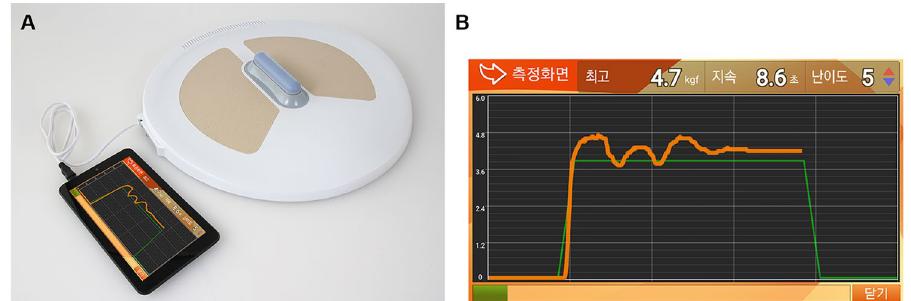
Figure 1. Image shows an extracorporeal perineometer used to measure the pelvic floor muscle strength (AnyKegel). ( A ) The perineometer shows a smart phone-based display. ( B ) Image shows a display of the program during the